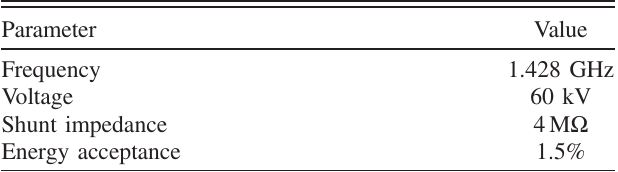
TABLE II. Radio-frequency